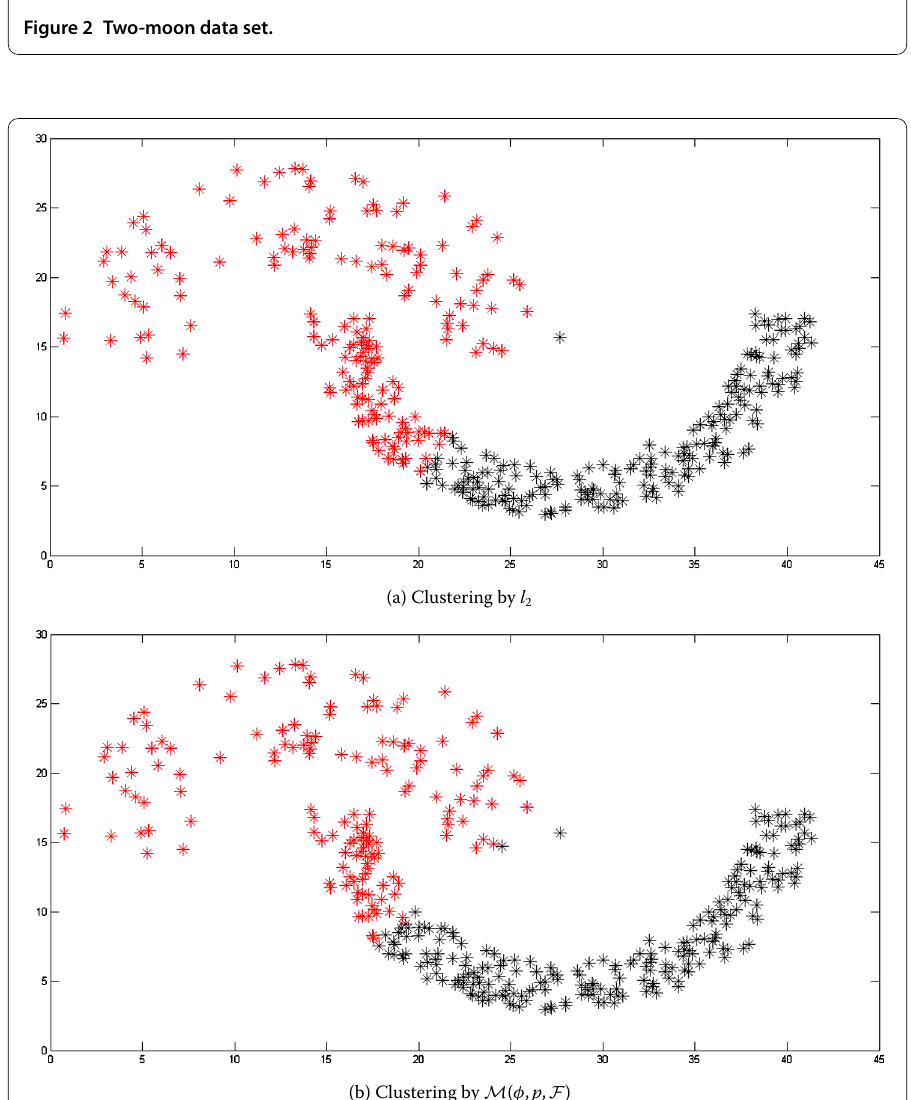
Figure 3 Obtained clustering results for two-moon data